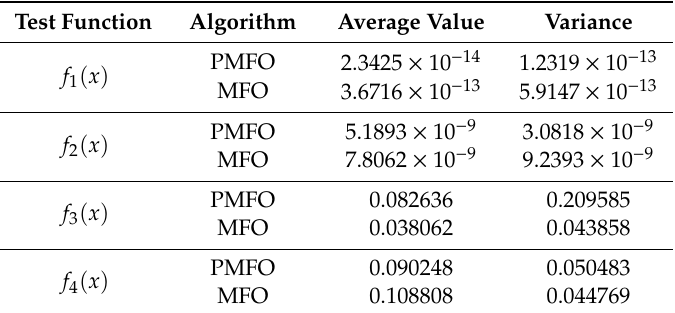
Table 6. Results of unimodal test functions.